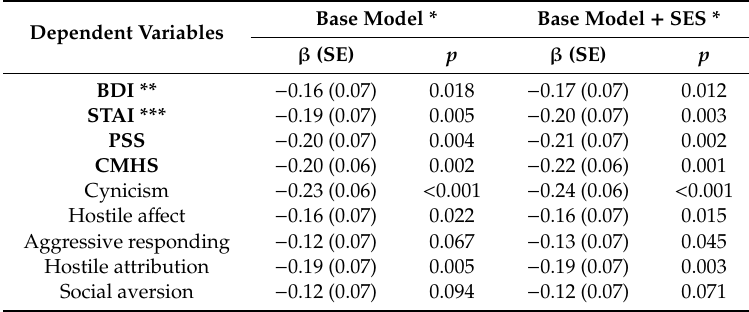
Table 2. Adjusted associations between mental health measurements and serum 25(OH)D concentrations.